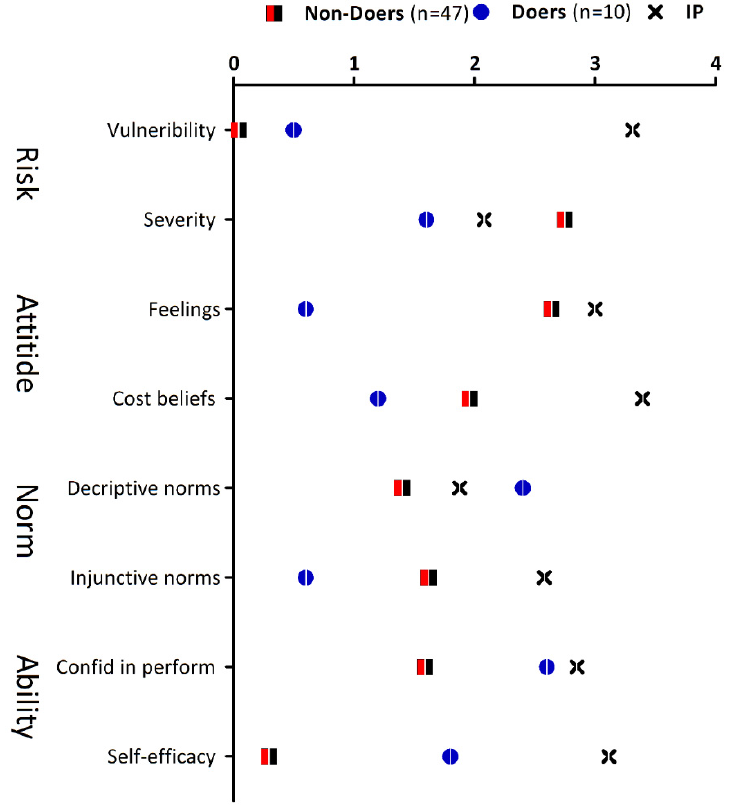
Figure 2. Results of the Risk, Attitude, Norm, Ability, and Self-regulation analysis, with a focus on risk and ability.